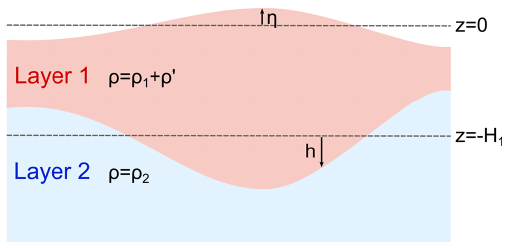
Figure 1. A schematic of the two-layer model used in the theoretical background.